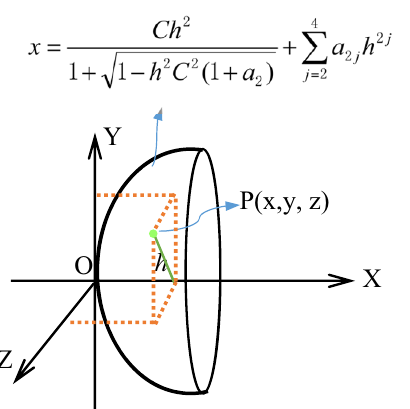
Figure 3. The geometric meaning of aspheric